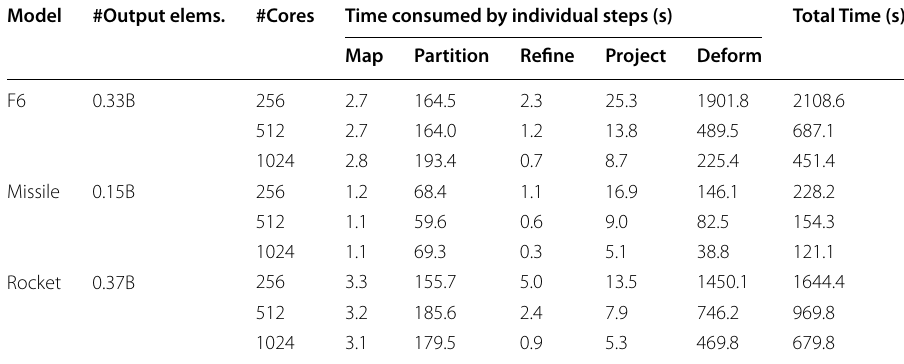
Table 3 Total timing data and breakdown of the overall refinement algorithm Model